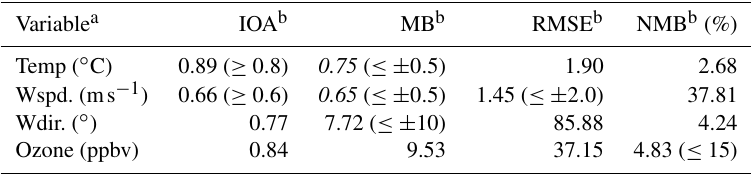
Table 3. Statistical comparison between the observed and simulated variables. The benchmarks are based on Emery et al. (2001) and EPA (Doll, 1991).